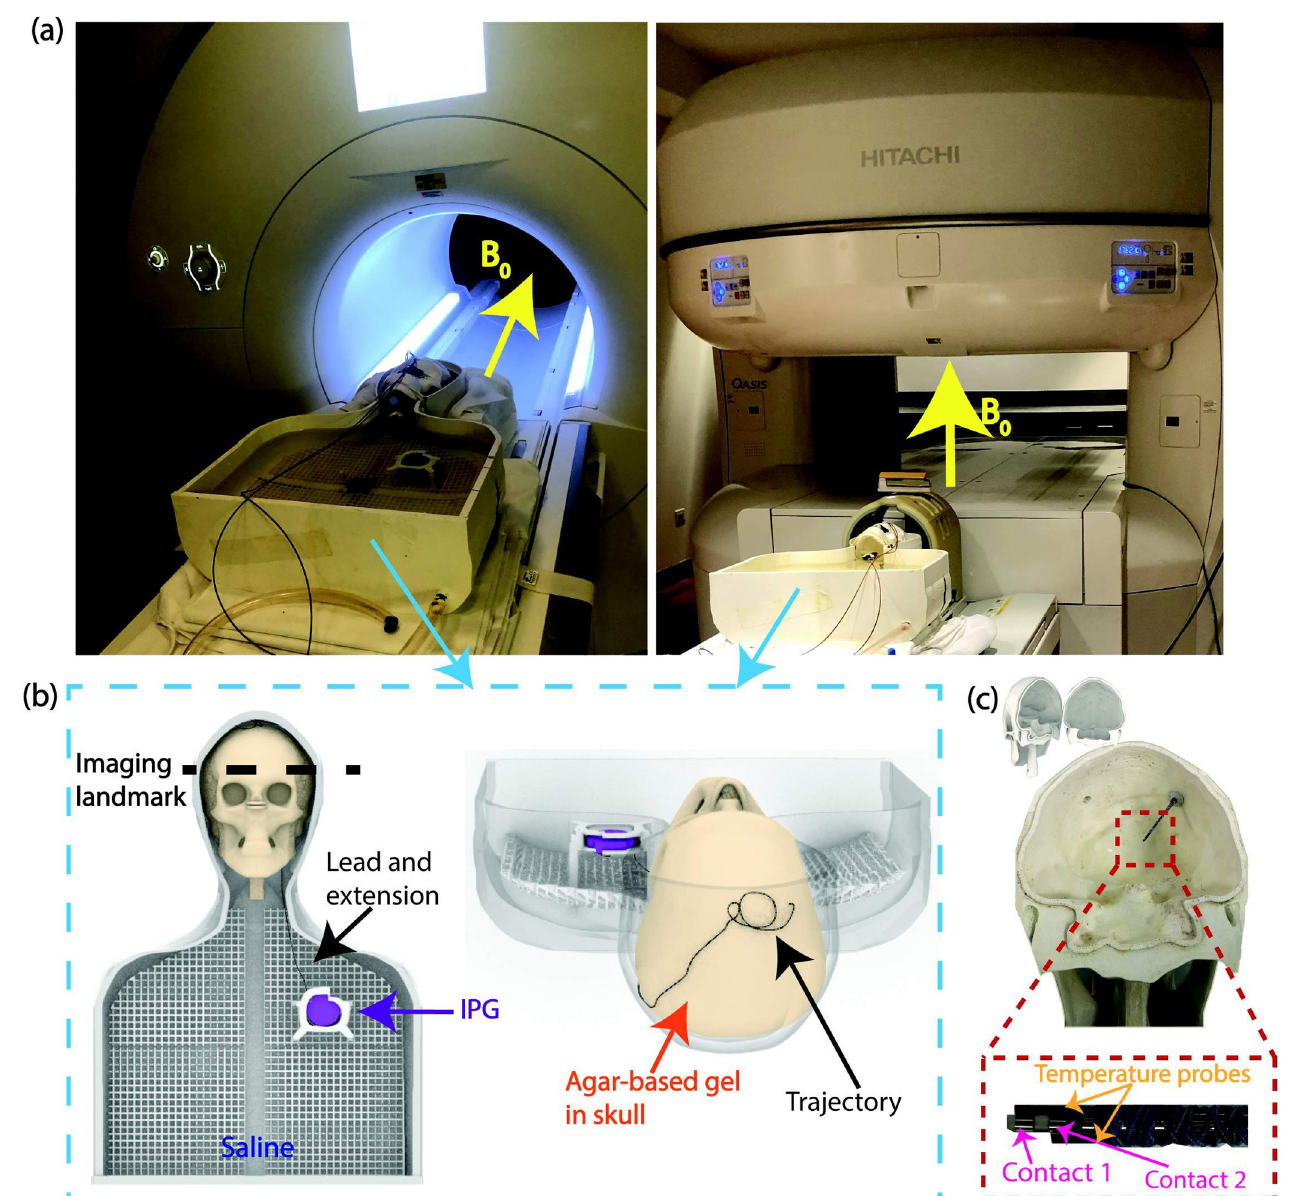
Fig 2. Experimental setup. (a). Anthropomorphic phantom with full DBS system implanted in the 1.5 T Aera horizontal scanner (left) and in the 1.2 T Oasis vertical scanner (right). (b) Rendering of anthropomorphic phantom components and a full DBS system implanted in the phantom. (c) 3D-printed skull with the DBS lead and temperature probes inserted. Temperature probes were attached to the lead to measure temperature rise at the distal